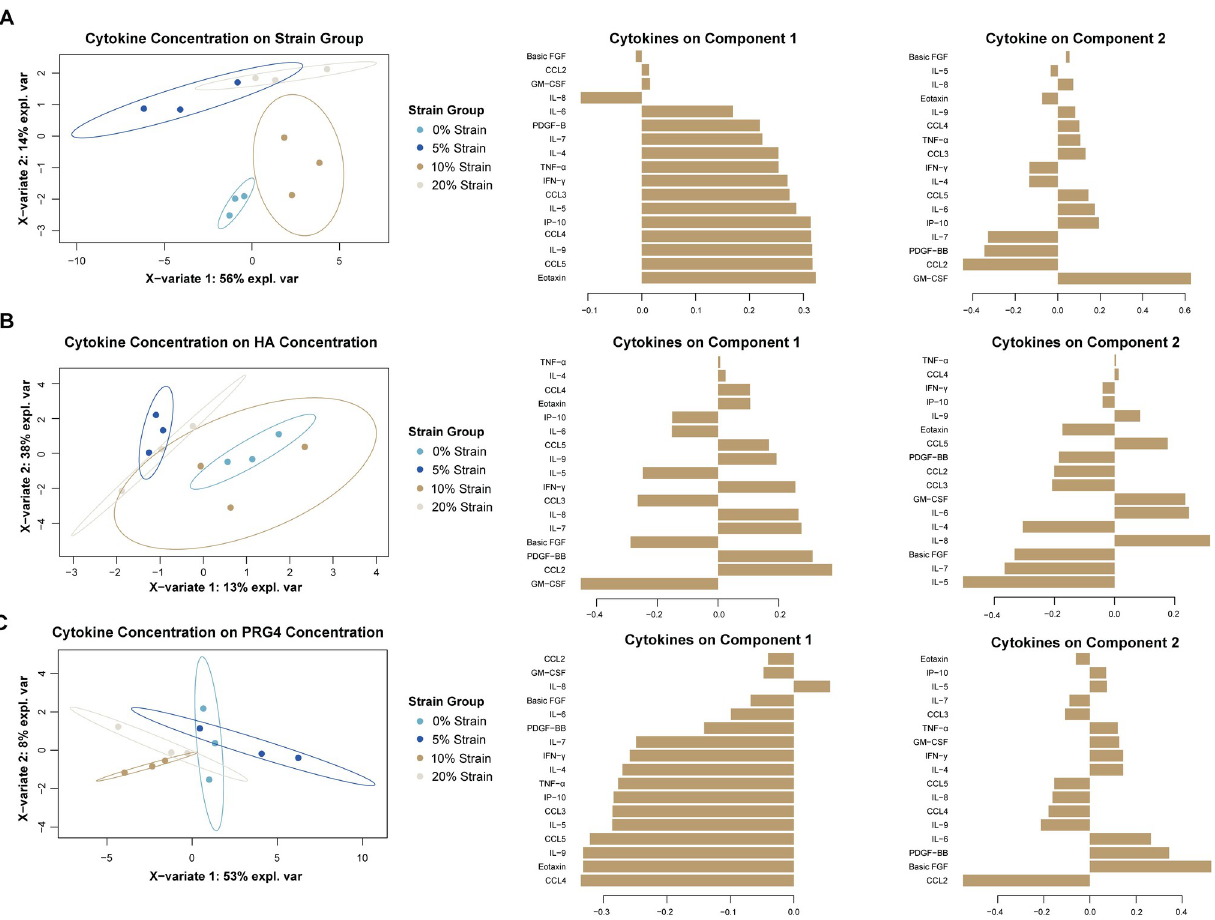
Fig 7. sPLS analysis of cytokine concentration to predict strain group, hyaluronan concentration, and PRG4 concentration shows distinct clustering between strain groups. A) sPLS-DA to predict strain group from cytokine concentration data, along with corresponding loadings plots, showing the contributions of each cytokine for each component. B) sPLSR to predict hyaluronan concentration group from cytokine concentration data, along with corresponding loadings plots, showing the contributions of each cytokine for each component. C) sPLSR to predict PRG4 concentration from cytokine concentration data, along with corresponding loadings plots, showing the contributions of each cytokine for each component. sPLS plots are shown in the X representative space of data along 2 components.